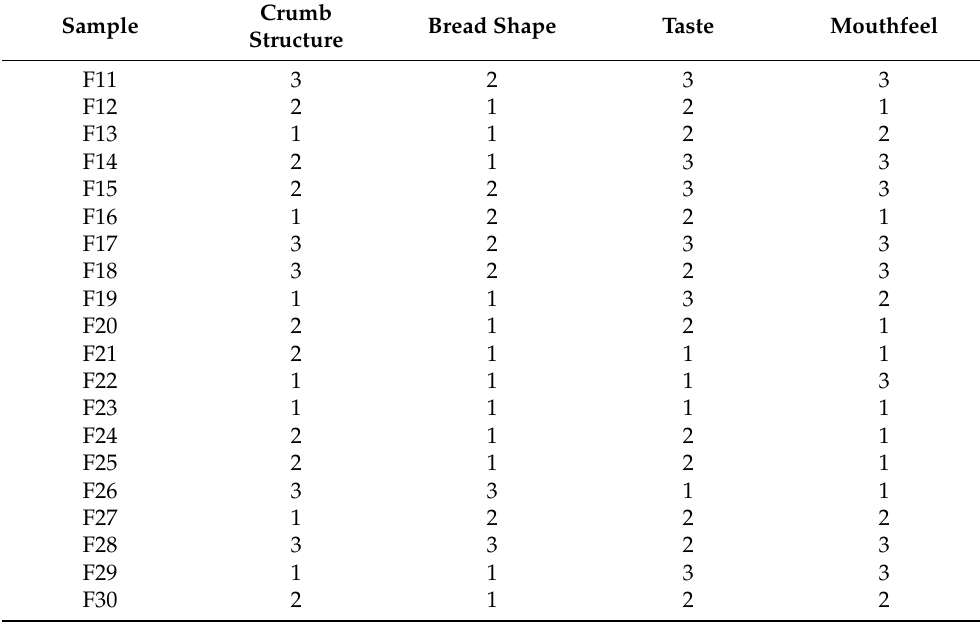
Table A1. The bread quality ratings of the oat cultivar samples evaluated by the two expert assessors. Bread crumb structure (evenness of the porosity), bread shape, taste, and mouthfeel were rated between 1–3 (3 excellent, 2 good, 1